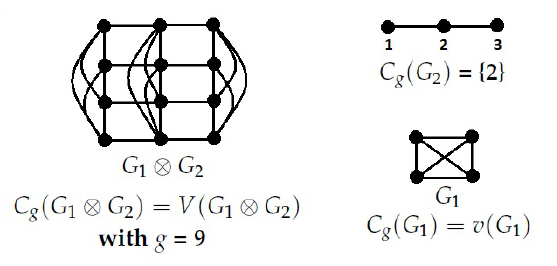
Figure 3. The proper containment of Proposition